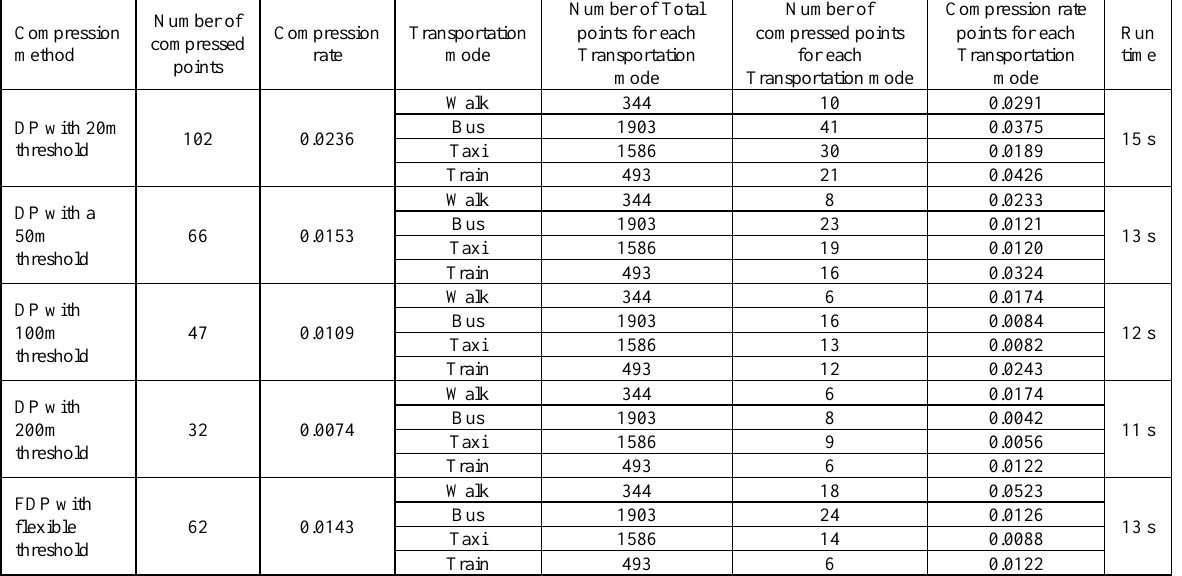
Table 2 . Results of compression